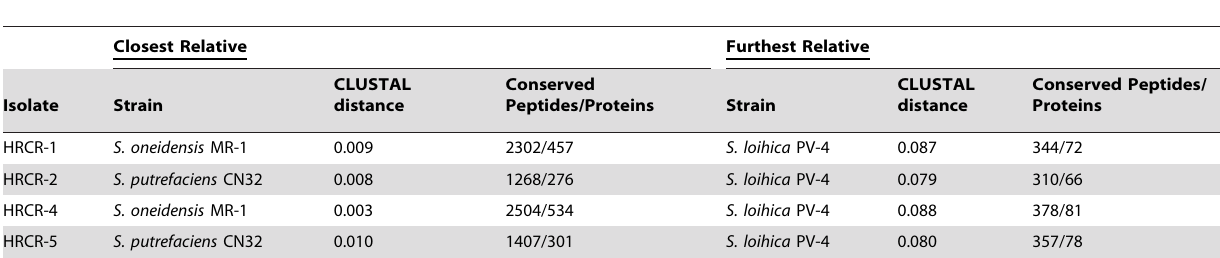
Table 1. Conservation of peptides amongst Shewanella isolates from the Hanford Reach of the Columbia River.